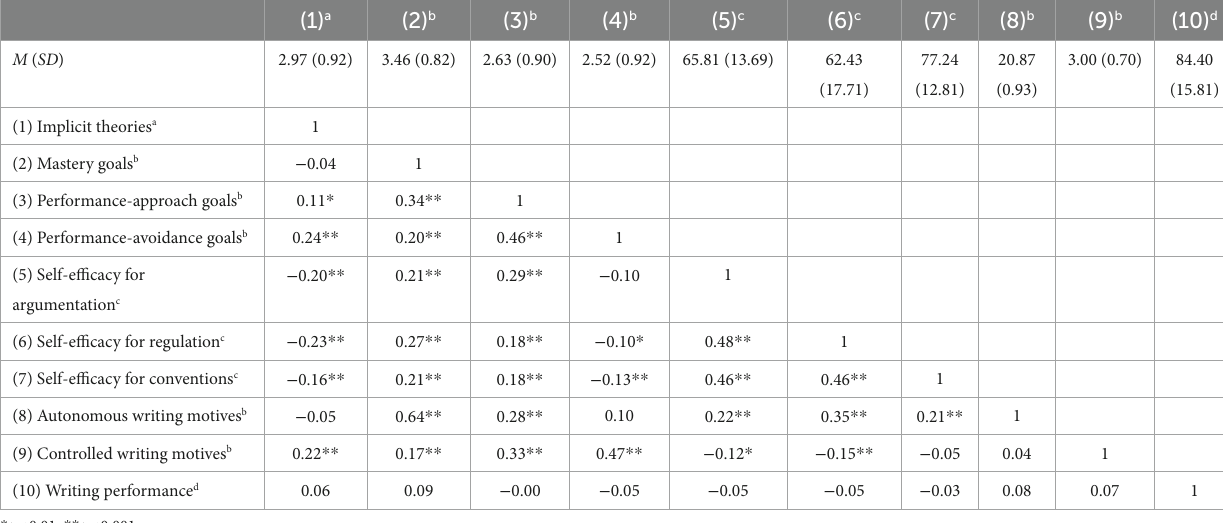
TABLE 1 Descriptive statistics and correlations for all study